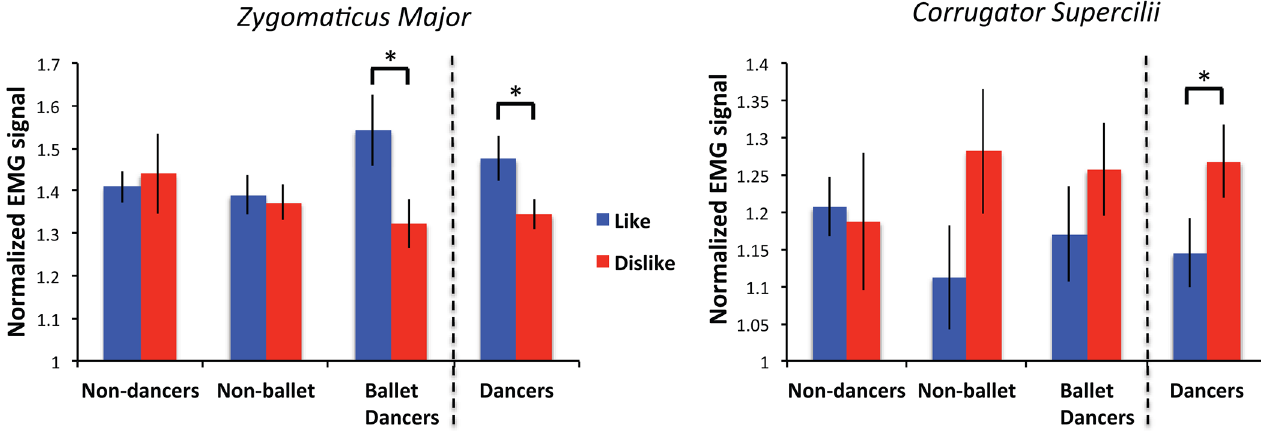
Fig 4. ZM and CS EMG signal by participant group: Non-dancers vs. non-ballet dancers vs. ballet dancers. These findings illustrate that the EMG signal of ZM was greater for liked videos among ballet dancers only. Error bars show +/- 1SEM and an asterisk ( * ) denotes a difference significant at p <